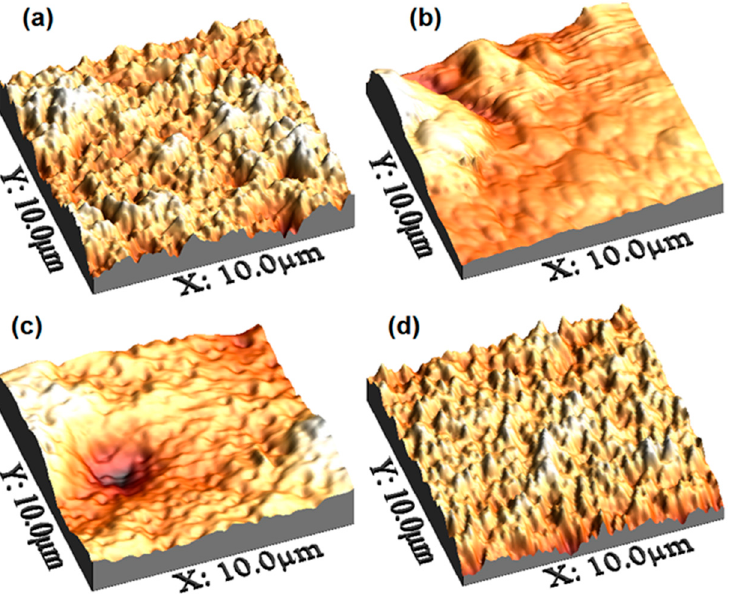
Figure 3. AFM images of ( a ) MoO 3 /PEDOT:PSS, ( b ) MoO 3 /PEDOT:PSS-A organotin (IV), ( c ) MoO 3 /PEDOT:PSS-B organotin (IV) and ( d ) MoO 3 /PEDOT:PSS-C organotin (IV) films.